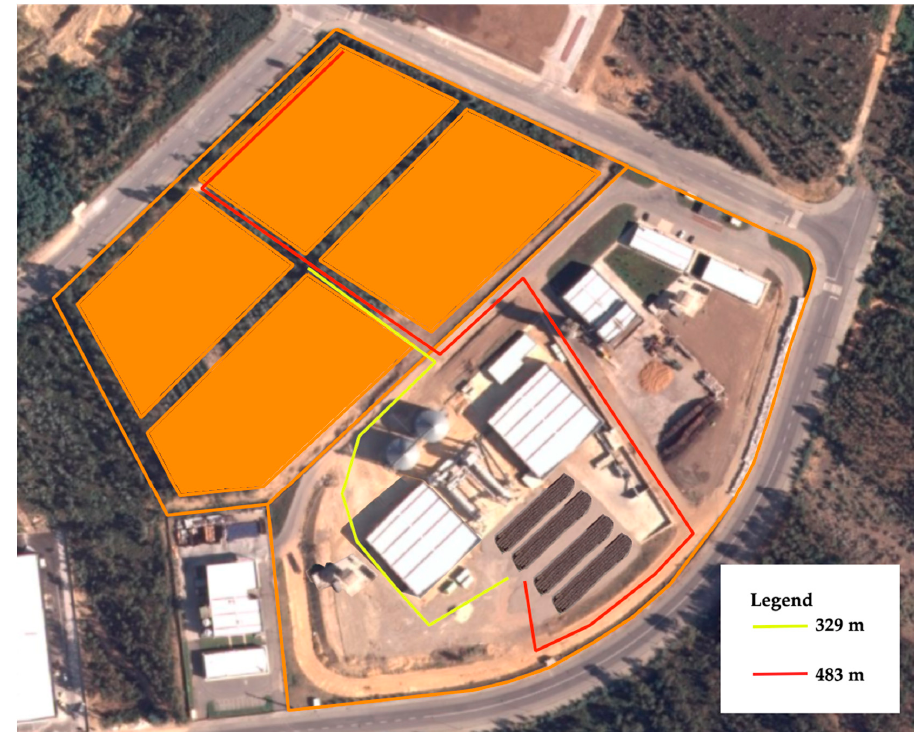
Figure 4. Representation of the worst-case route (in red) and average route (in yellow) between the two parks.